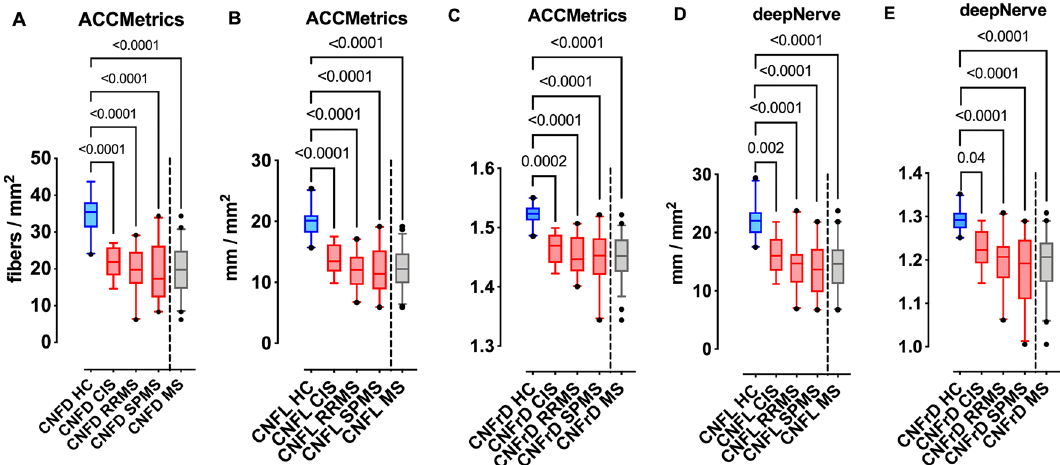
Figure 1. Graphs represent box (mean and interquartile range) and whiskers (5th and 95th percentile) plots with outliers (solid black dots). Blue color corresponds to HC, red to different MS courses and grey to the whole MS group. Graphs ( A ) CNFD, ( B ) CNFL and ( C ) CNFrD correspond to classification performance as measured by ACCMetrics; and graphs ( D ) CNFL and ( E ) CNFrD correspond to Voxeleron